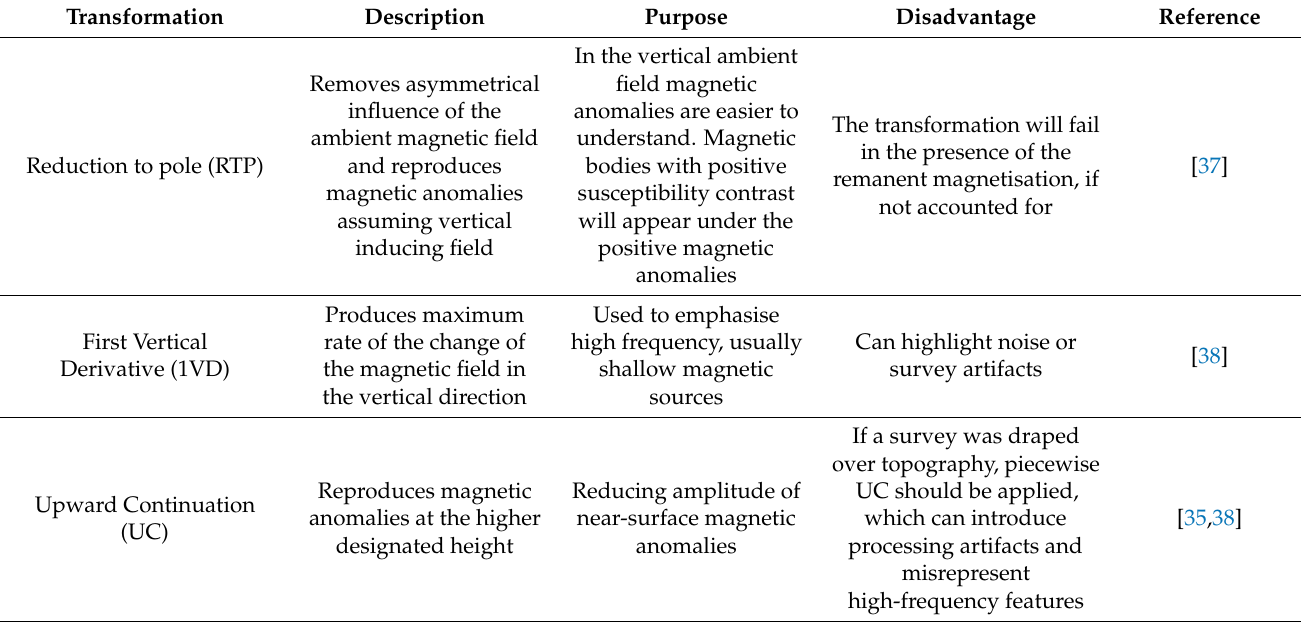
Table 2. Transformations applied to the aeromagnetic data.